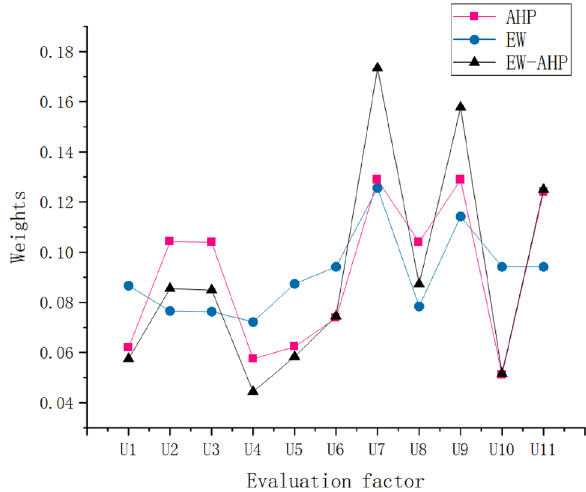
Figure 7. EW-AHP coupling weights.